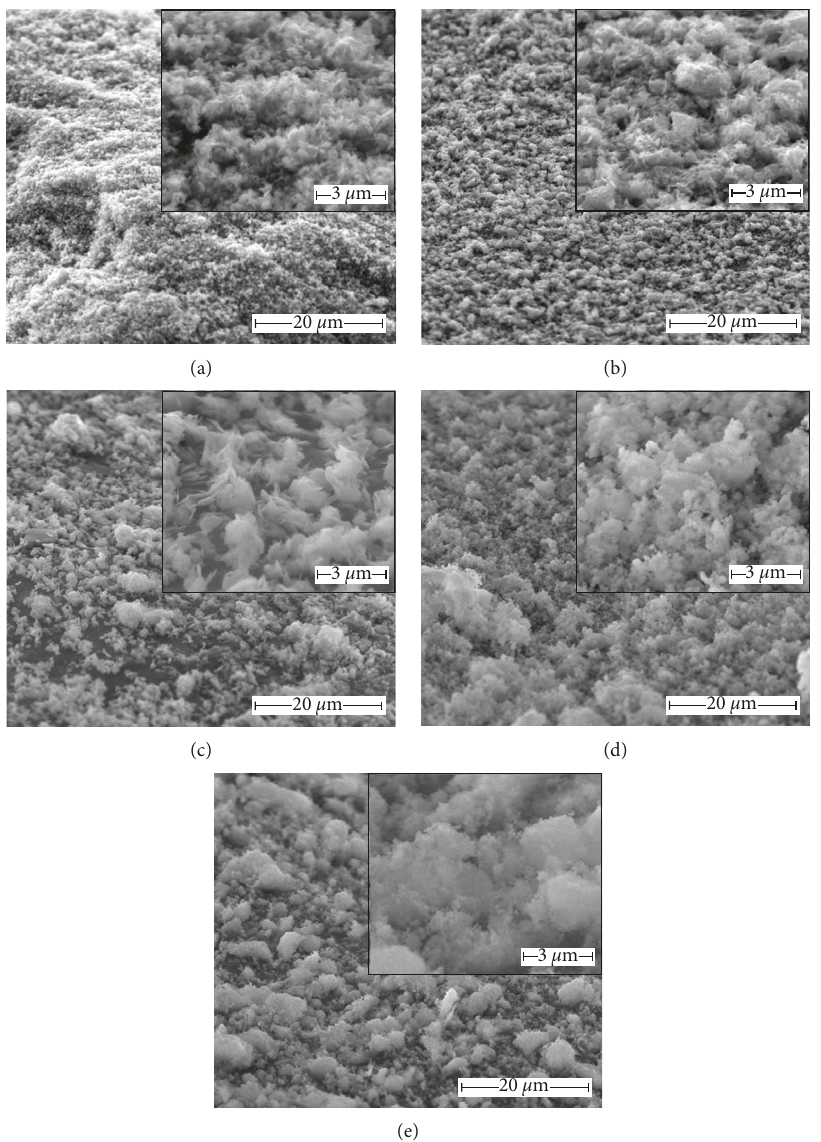
Figure 3: SEM microphotographs of ZnO (a), Zn(OH) by the precipitation or solid-state (ZnCO 3 )